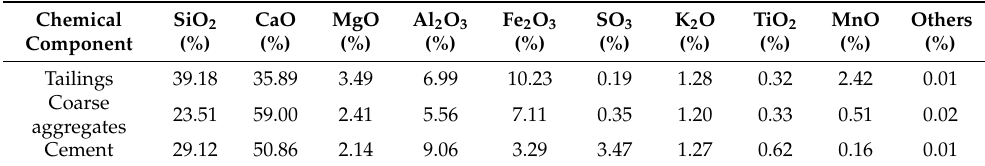
Table 3. Chemical components of solid